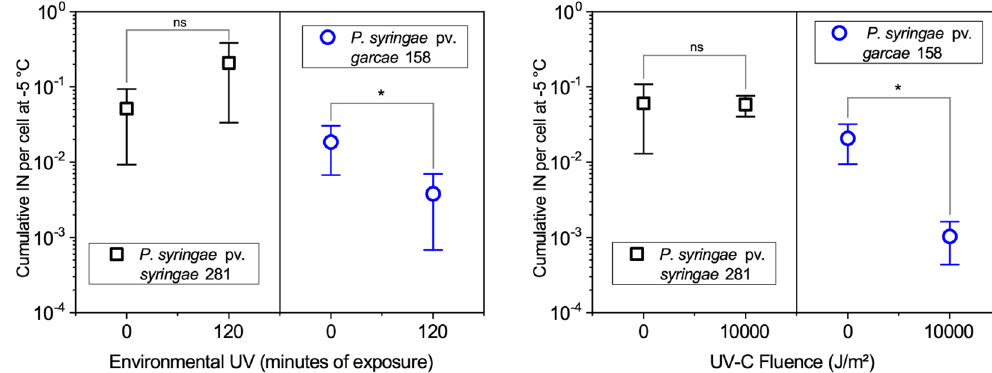
Figure 6. IN activity following prolonged exposures to “environmental” UV radiation (UV-A + UV-B) (right panel) and to UV-C (254 nm) radiation (left panel). For the “environmental” UV, when compared to non- irradiated controls (“0 min”), the concentration of cumulative ice nuclei (IN) per cell at − 5 °C of P. syringae pv. syringae 281 exposed for two hours suffered no significant change, while P. syringae pv. garcae 158 samples exhibited an up to 10-fold reduction. The IN of P. syringae pv. syringae 281 exposed to 10,000 J/m 2 of UV-C remained stable when compared to non-irradiated controls (“0 J/m 2 ”). P. syringae pv. garcae 158, instead, was reduced by about 20-fold. Error bars denote standard deviations of the means (n = 7 for 281 and n = 5 for 158 for the “environmental” UV experiments, n = 6 for 281 and n = 7 for 158 for the UV-C experiments). Based on the Mann-Whitney U test, significantly different values are marked as * (p < 0.05) and non-significant differences as “ns”.